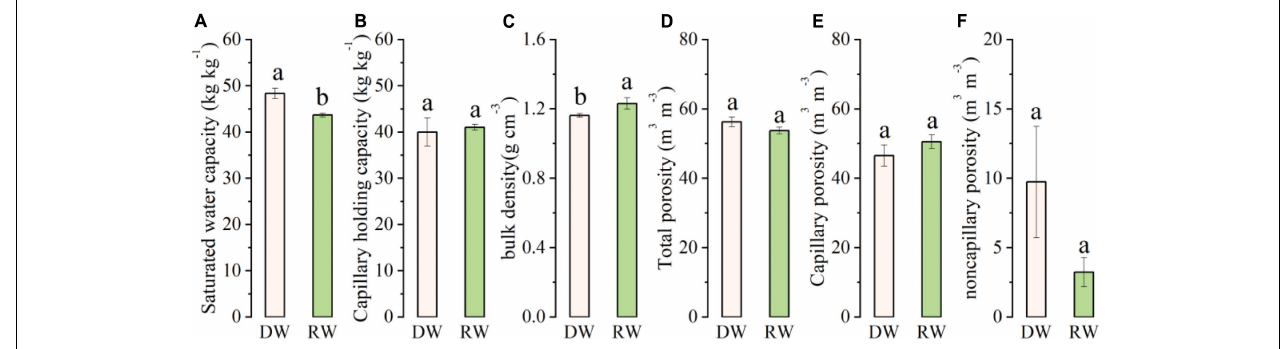
FIGURE 3 | The characteristics of soil physical properties under rice–wheat (RW) and dryland crop–wheat (DW): (A) saturated water capacity; (B) capillary holding capacity; (C) bulk density; (D) total porosity; (E) capillary porosity; and (F) non-capillary porosity. Means and standard error ( n = 3). Bars with different lower-case letters indicate significant differences at p <